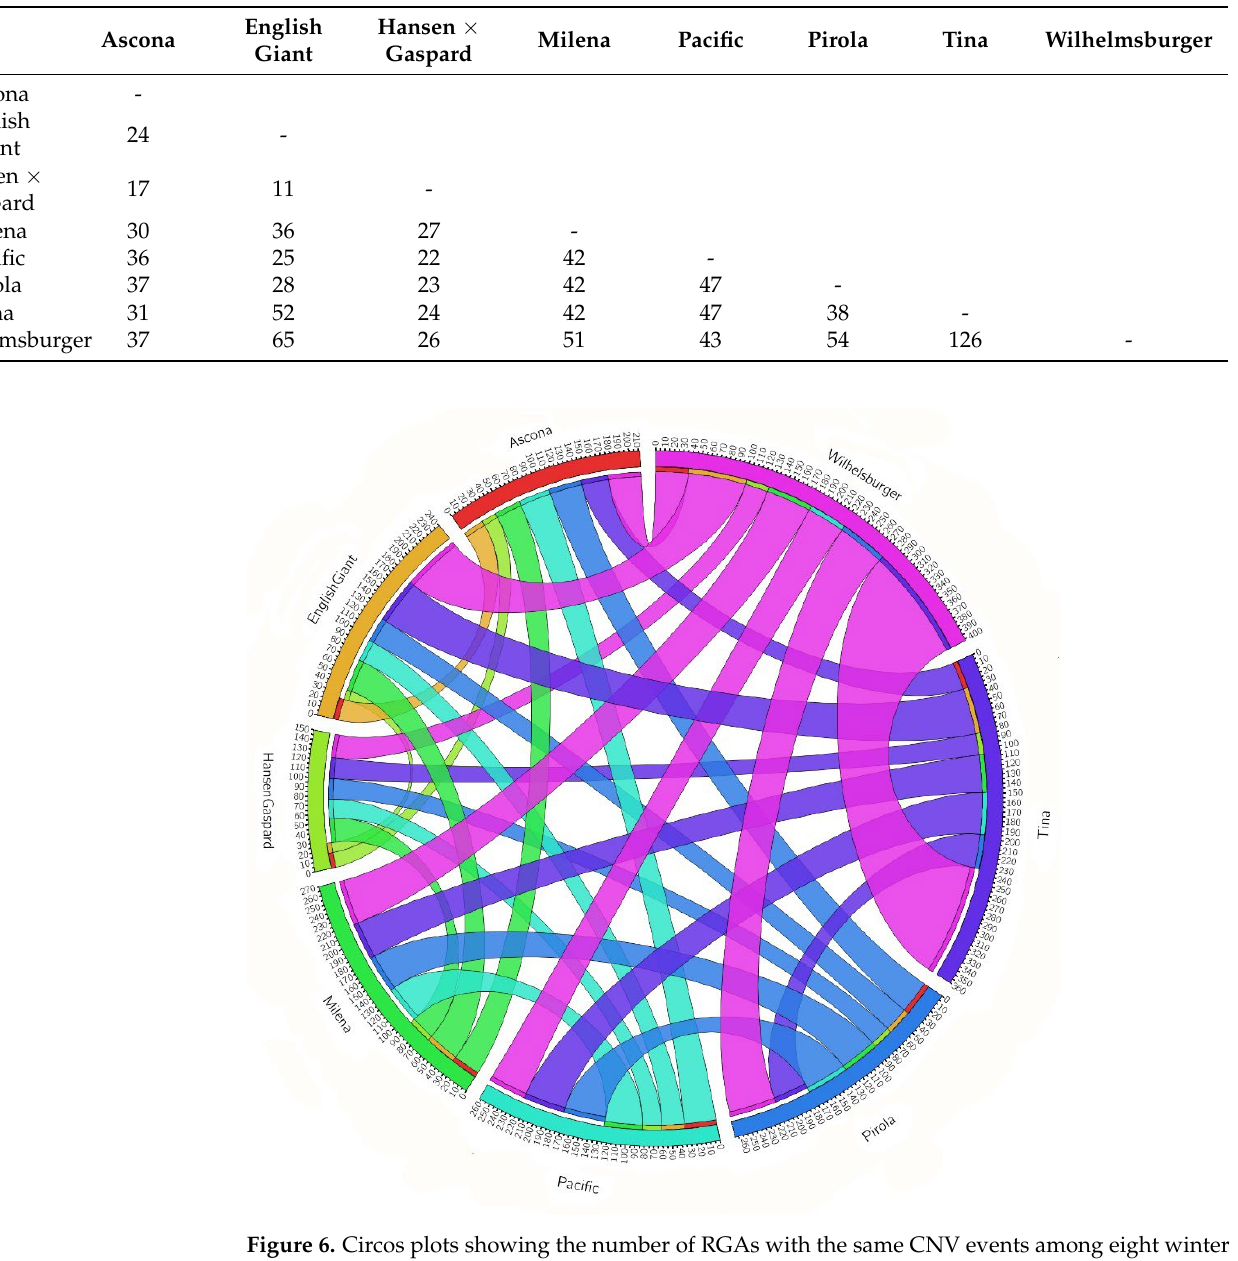
Table 2. The number of RGAs with the same CNV type in eight B. napus cultivars.